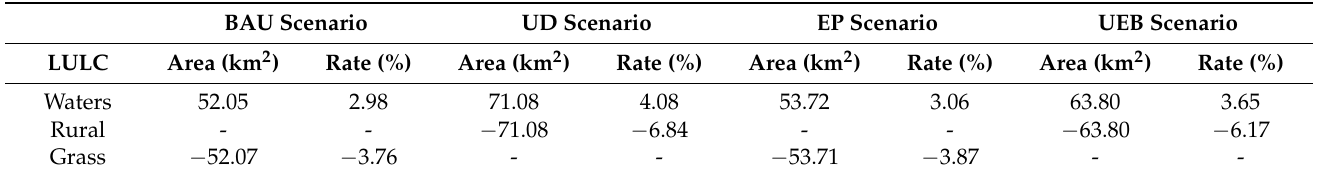
Table 4. The difference between the results simulated by PLUS model and the Markov chain